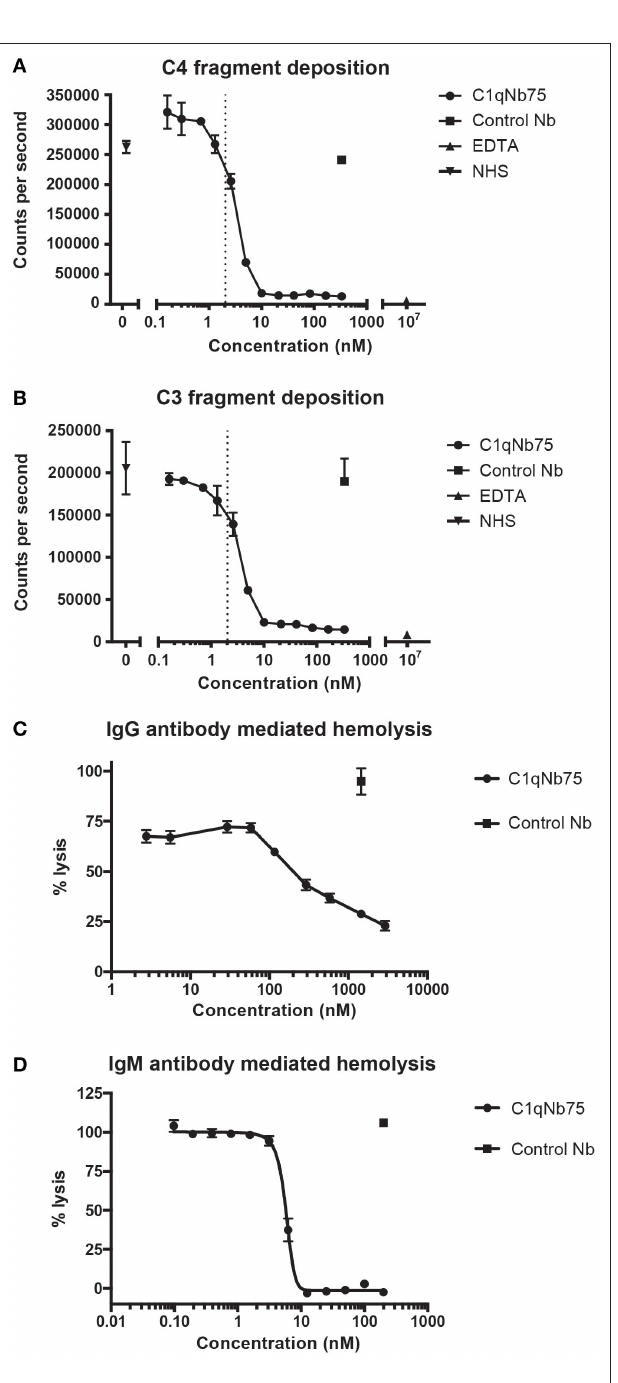
FIGURE 3 | C1qNb75 inhibits IgG and IgM mediated activation of the classical pathway and hemolysis. (A) Deposition of C4 fragments on IgG coated surface from 0.2% NHS in the presence of increasing concentrations of C1qNb75, control Nb (333nM) or EDTA (10 µ M). Shown are mean and SD of two independent experiments. The dotted line indicates the calculated Nb concentration resulting in a 1:1 binding to gC1q. (B) As in panel A, but measuring C3 fragment deposition. (C) Hemolysis of sheep RBCs sensitized with IgG in the presence of increasing concentrations of C1qNb75, control Nb or EDTA. Data are plotted as % lysis where 100% lysis is incubation of RBCs with water. Results are representative of two similar